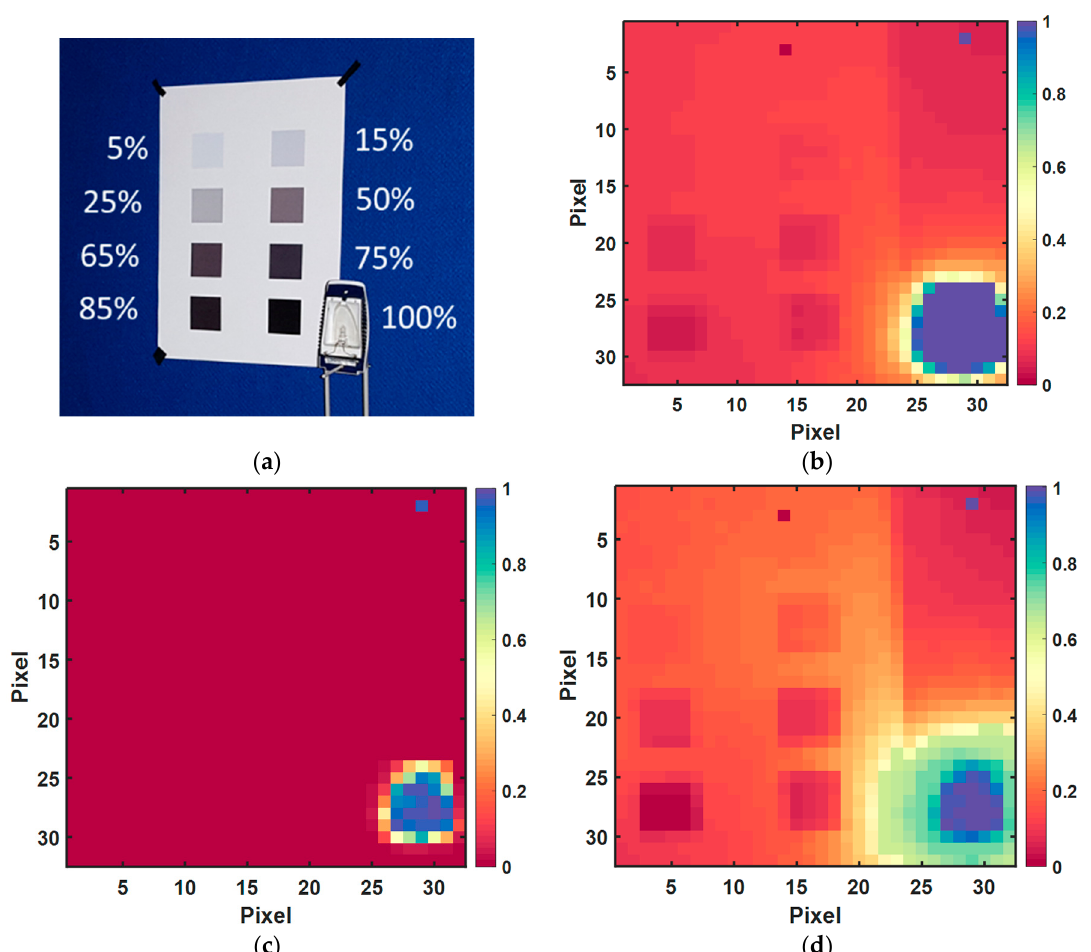
Figure 7. Images captured by SuperEllen sensor with 30-ms of exposure time: ( a ) the captured scene, acquired with a conventional camera with typical indoor illumination and the lamp switched off; ( b ) image based on the photon counts; ( c ) image based on the photon arrival times; ( d ) high dynamic range (HDR) image obtained with the proposed method.